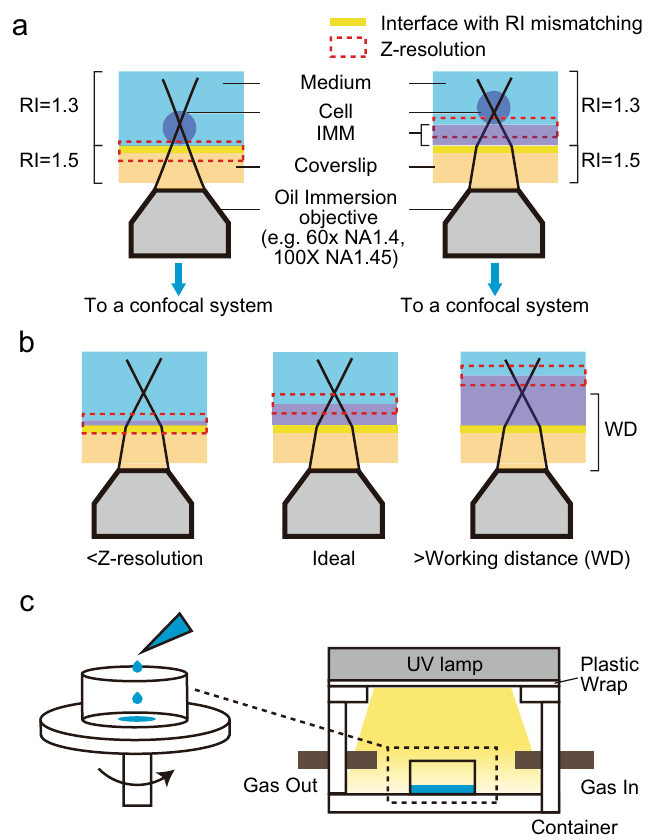
Figure 1. Experimental setup. ( a ) Schematic illustration of experimental setup of conventional type (left) and present type (right). ( b ) Schematic illustration of layer thickness under given z-resolution and working distance. ( c ) The schematic for preparation of fluorinated acrylic polymer